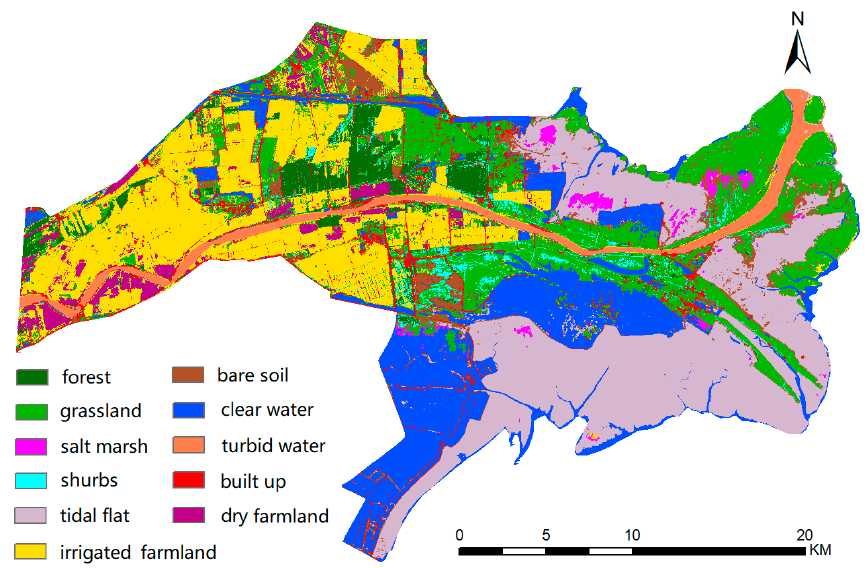
Figure 8. Classification map of the Yellow River Delta generated by the multibranch CNN.